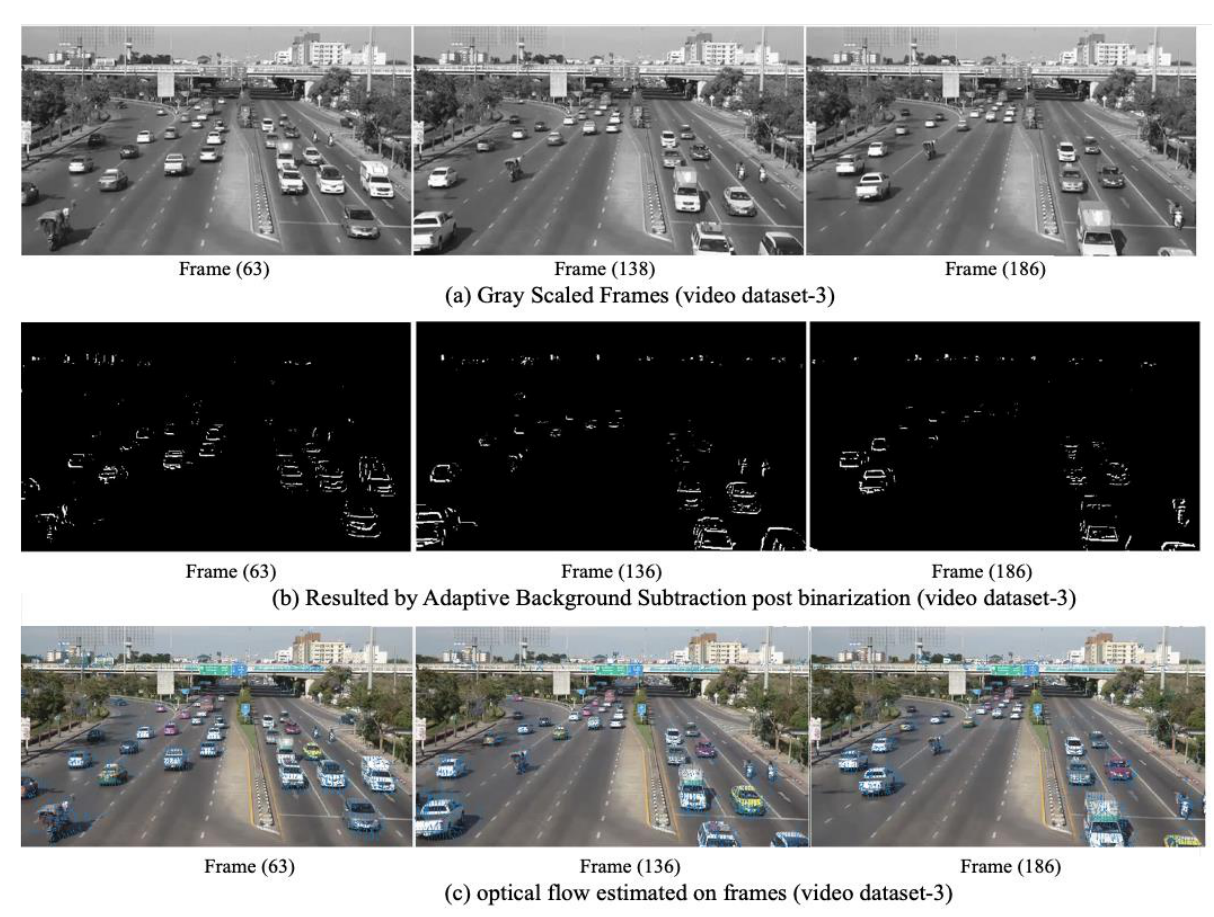
Figure 7. Activity map and pixel sensitivity maps of video dataset 2 by different approaches: ( A ) by Pan et al. in [12]; ( B ) by Mehboob et al. in [13]; ( C ) by Indu, S. in [14]; ( D ) our proposed framework. C. Video dataset 3 (Traffic surveillance):